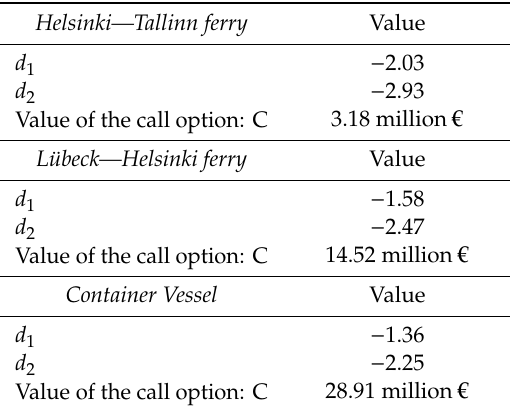
Table 9. ROA Values for a Deferral Call